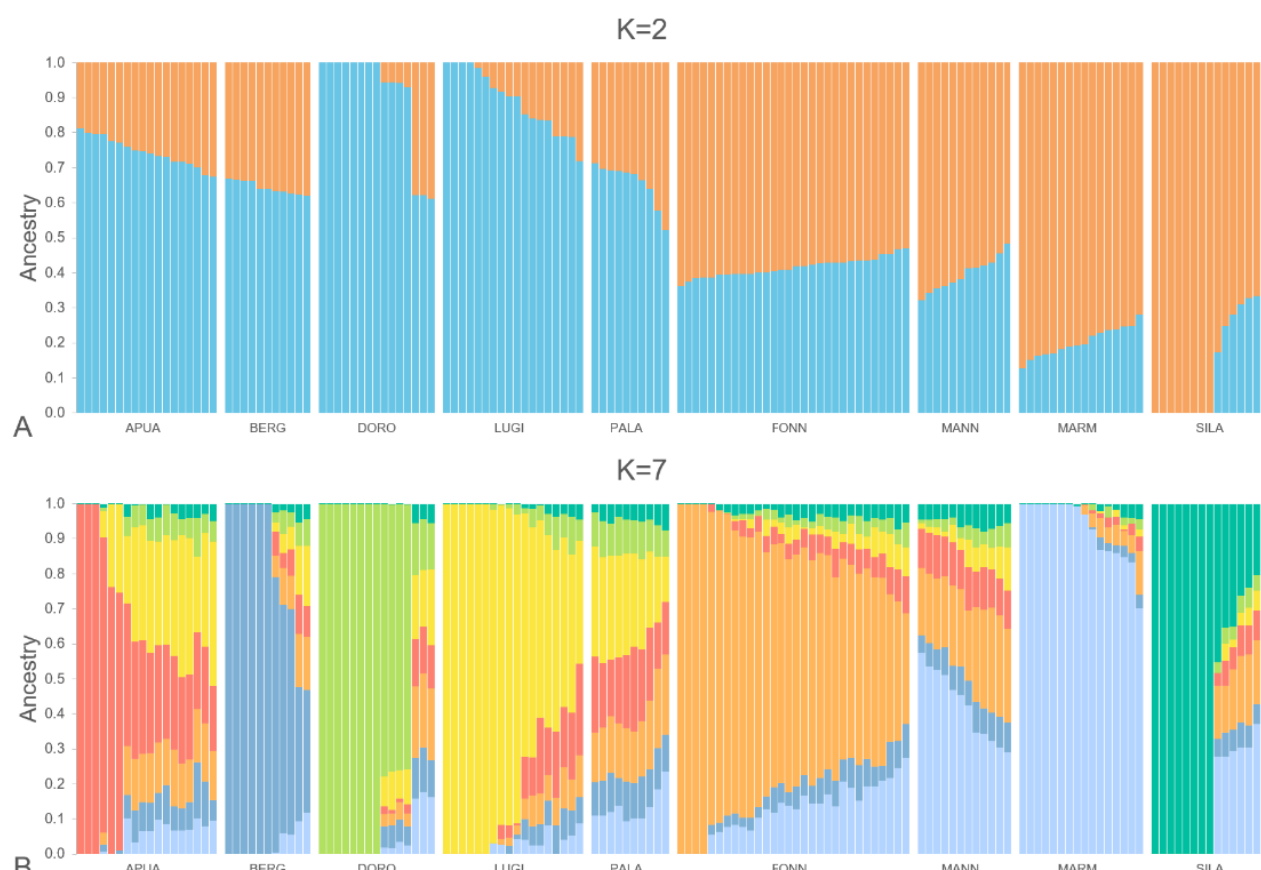
Figure 2. Admixture analysis of all the enrolled individuals, considering a number of clusters (K) equal to two ( A ) and seven ( B ), which resulted in the best fitting model. Each colour represents a different cluster. Herding dog breeds: Pastore Apuano (APUA), Bergamasco shepherd dog (BERG), Pastore d’Oropa (DORO), Lupino del Gigante (LUGI), and Pastore della Lessinia e del Lagorai (PALA); livestock guardian breeds: Fonni’s dog (FONN), Mannara dog (MANN), Maremma and the Abruzzi sheepdog (MARM), and Pastore della Sila (SILA).